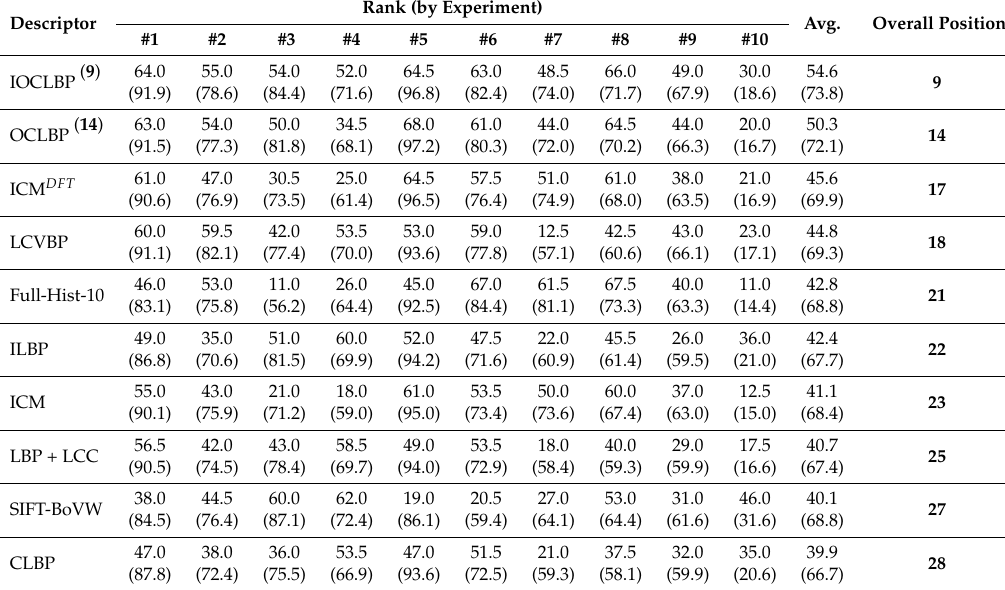
Table 4. Hand-crafted descriptors: relative performance of the best ten methods at a glance. For each method, the columns from #1–#10 show the rank (first row) and average accuracy (second row, in parentheses) by experiment. The next to last column reports the average rank and accuracy over all the experiments and the last column the overall position in the placings.